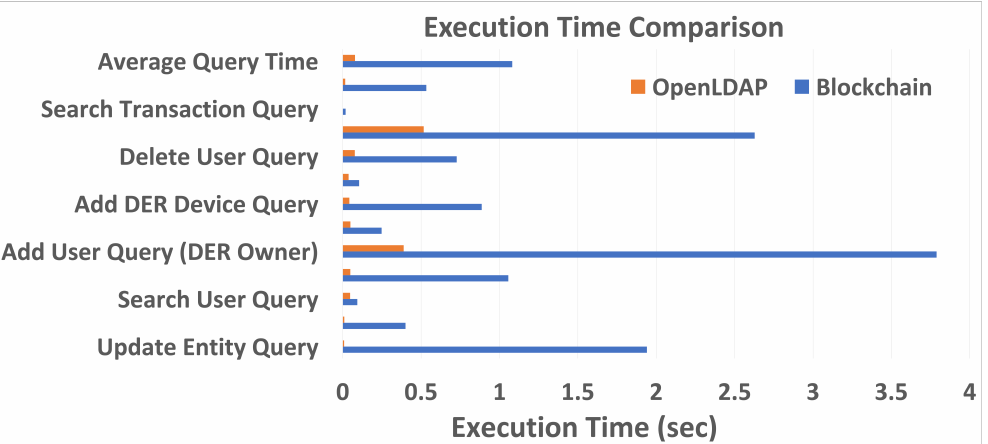
Figure 11. Centralized and Decentralized Query Execution